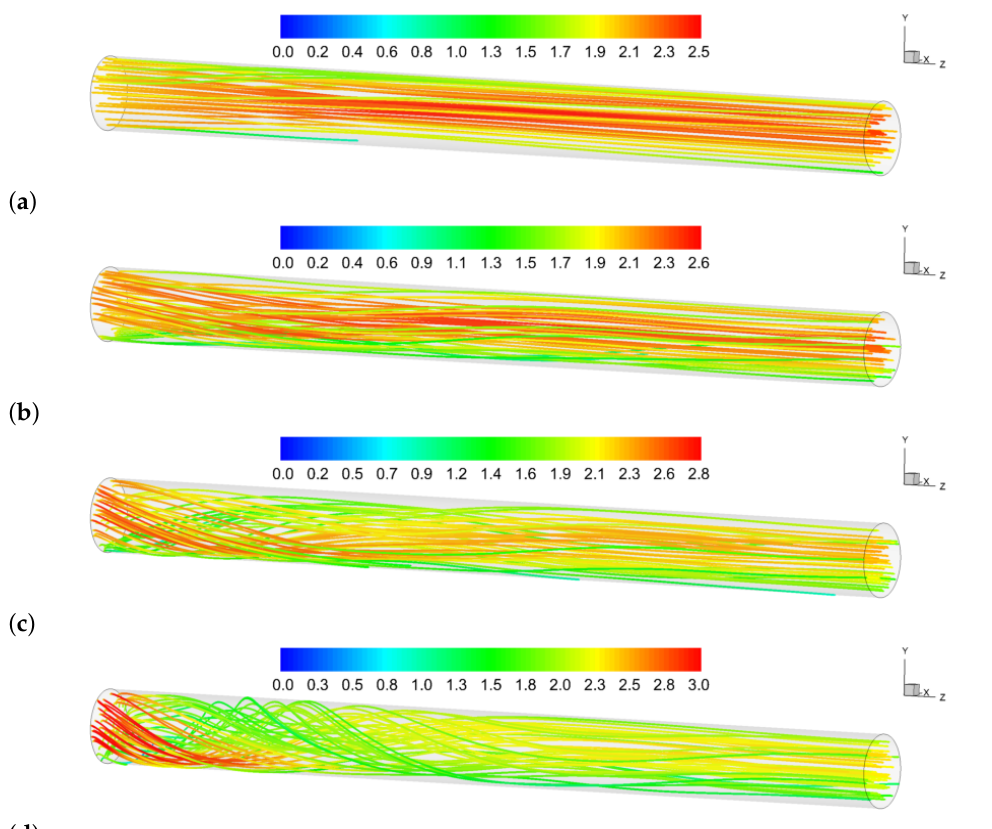
Figure 7. Axial velocity streamlines: ( a ) SR = 0; ( b ) SR = 0.1; ( c ) SR = 0.25; ( d ) SR =